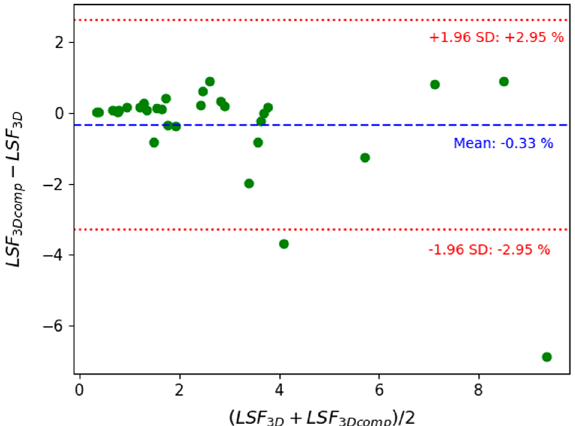
Fig. 4 Bland–Altman plot of the LSF (%) between 3D and 3Dcomp reconstructions for each patient. LSF 3D and LSF 3Dcomp correspond to the LSF estimated from the 3D and 3Dcomp reconstructions,